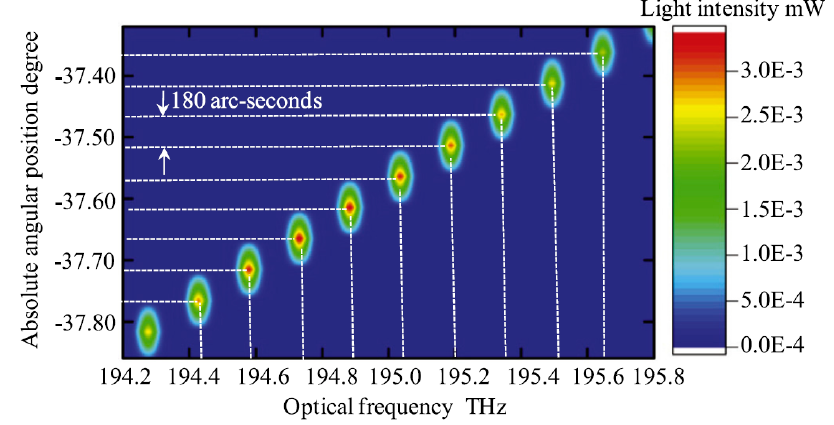
Figure 10. An example of the absolute angular position measurement by the optical frequency-domain femtosecond laser autocollimator [57]. femtosecond laser autocollimator